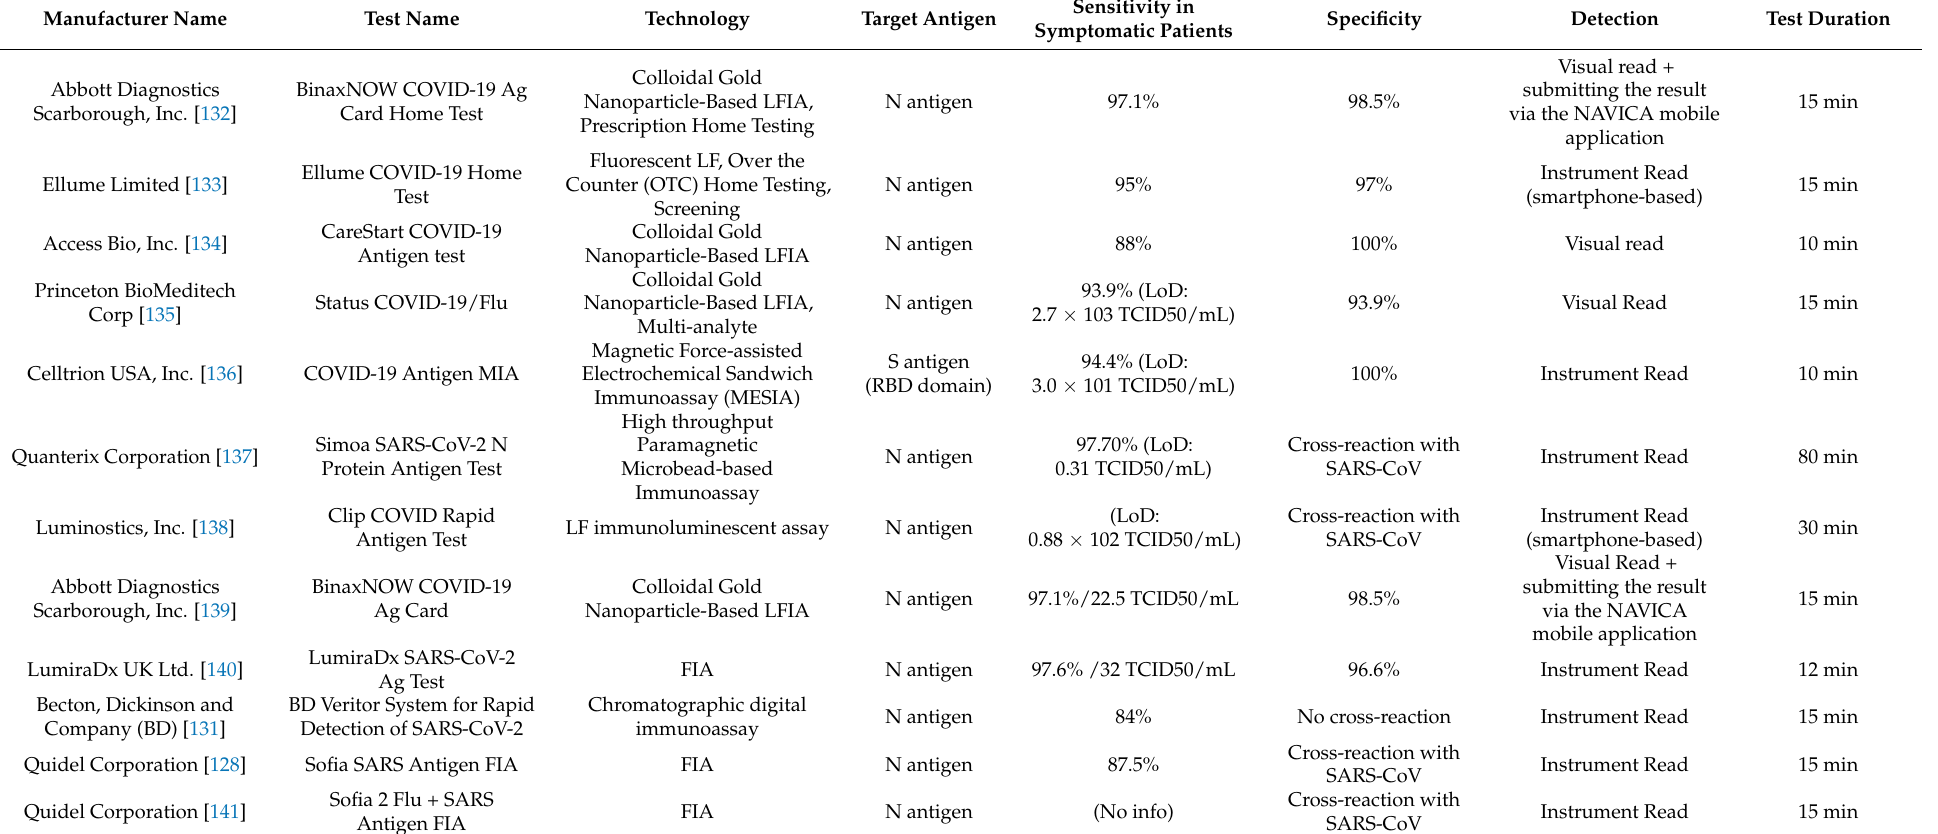
Table 5. A list of the developed Antigen-based tests for COVID-19